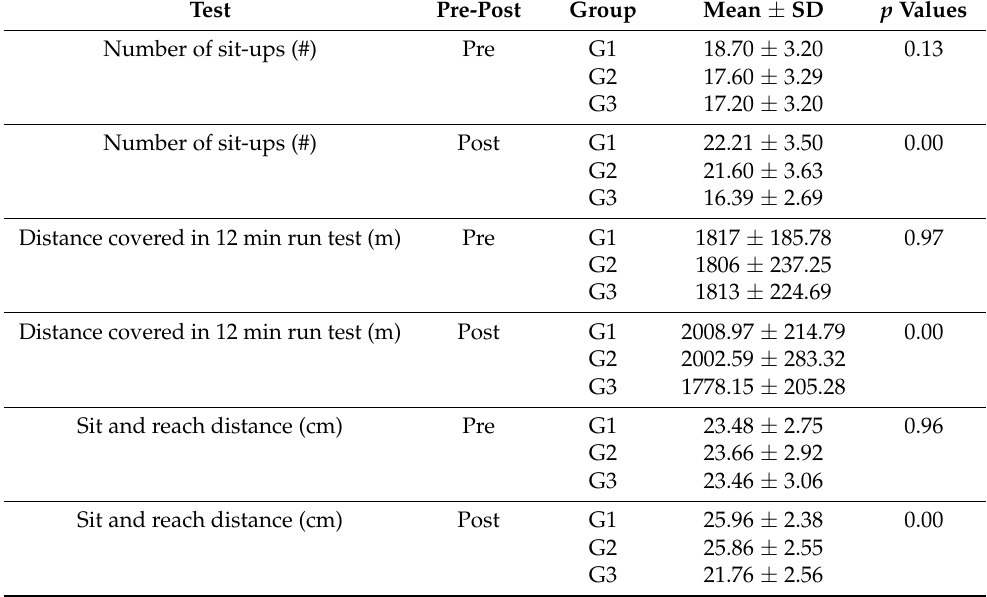
Table 2. Pre- and post-12-week changes in physical fitness variables among school-aged athletes.